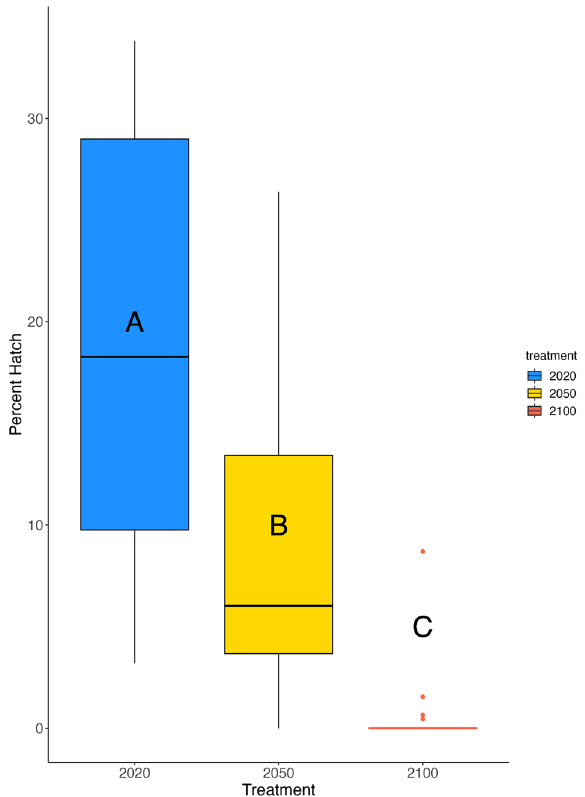
Figure 1. Boxplots illustrating the median, upper and lower quartile, and interquartile range of percent total hatch for the year 2020 (blue), year 2050 (yellow), and year 2100 (red) treatments. The average percent hatch was 19% for the year 2020 treatment, 9% for the year 2050 treatment, and 0.6% for the year 2100 treatment. GLMMs with a beta distribution were run to determine statistical significance, letters indicate significant